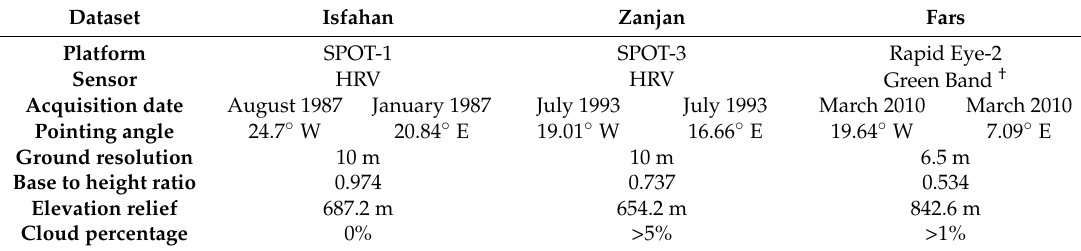
Table 2. Specifications of the datasets used.